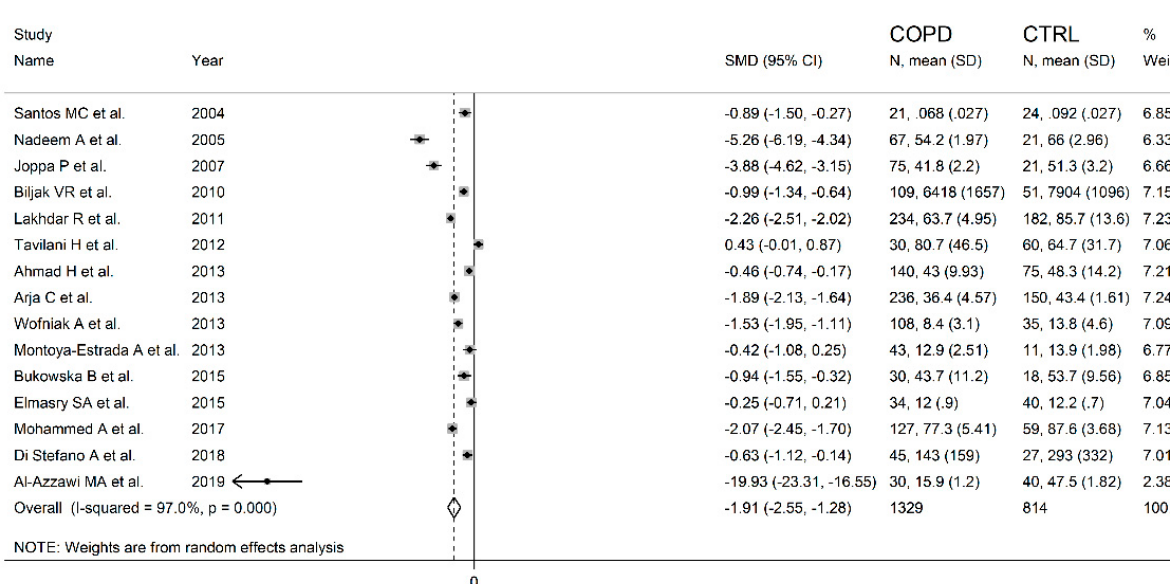
Figure 2. Forest plot of studies examining blood/erythrocytes GPx values of COPD and non-COPD.